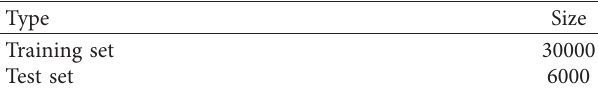
Table 3: Simulation data